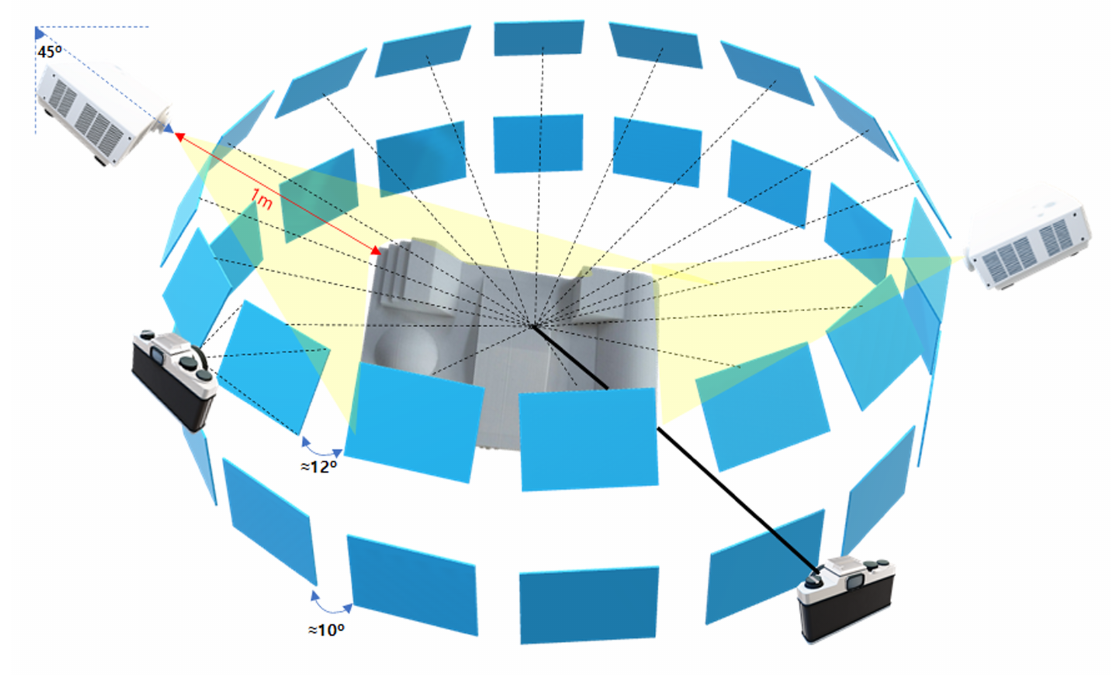
Figure 4. Image acquisition scheme for the test object using two projectors and one